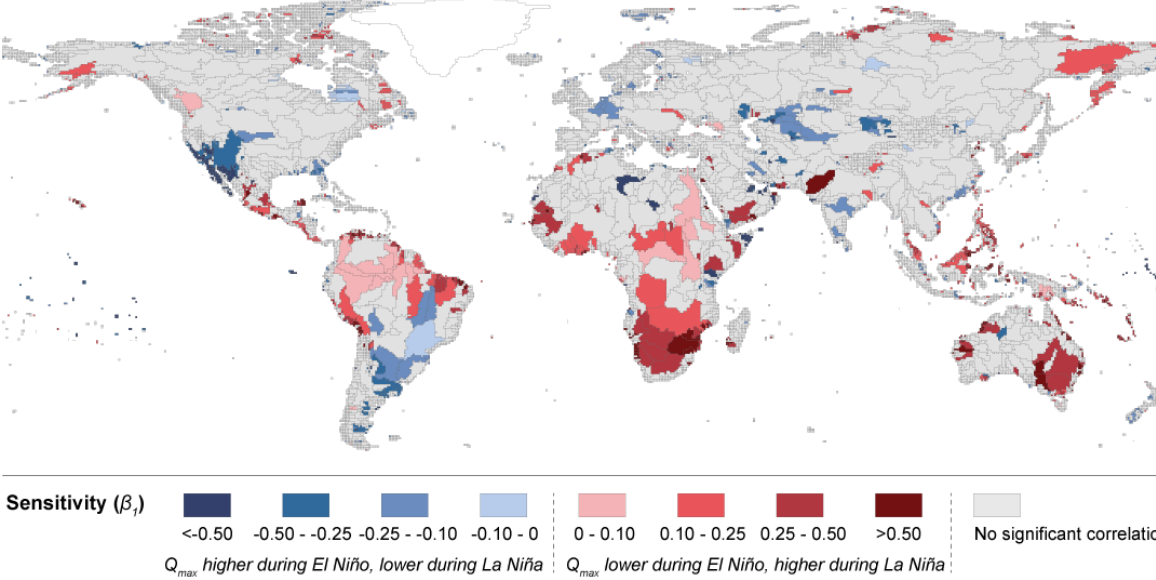
Fig. A3. Sensitivity ( β 1 ) of ln Q max to variations in SOI. Sensitivity is only shown for basins with significant correlation at a 5% confidence interval (Pearson’s r , t statistic, α = 0 . 05). Negative correlation generally represents higher annual floods in El Niño years/lower annual floods in La Niña years, while positive correlation generally represents the opposite.